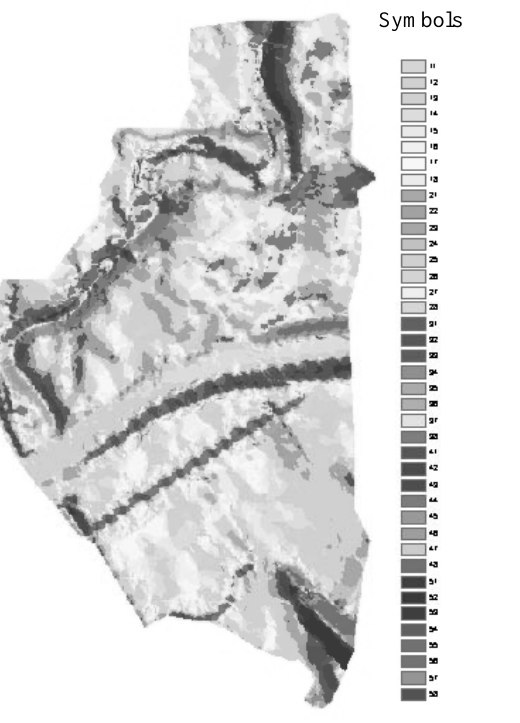
Fig 5. Aspect classification map